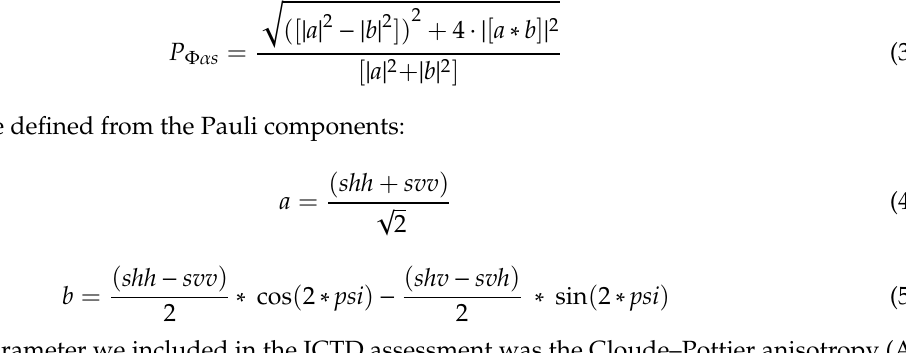
apply the Bhattacharyya Distance to determine the spectral signature separability between areas